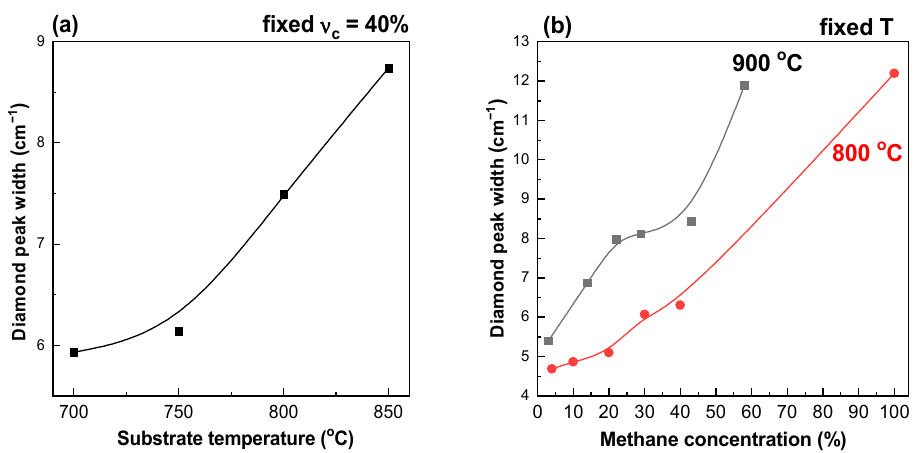
Figure 7. Diamond Raman peak width (FWHM) for films grown: ( a ) at fixed CH 4 to total flow concentration ν c = 40% and different substrate temperatures; ( b ) at fixed substrate temperatures 800 and 900 °C depending on the methane concentration. The lines are guides for the eye.